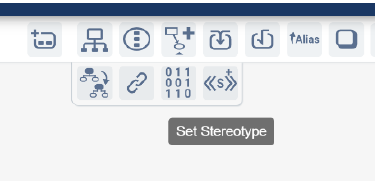
Figure 6. The Set Stereotype button in OPCloud secondary toolbar.